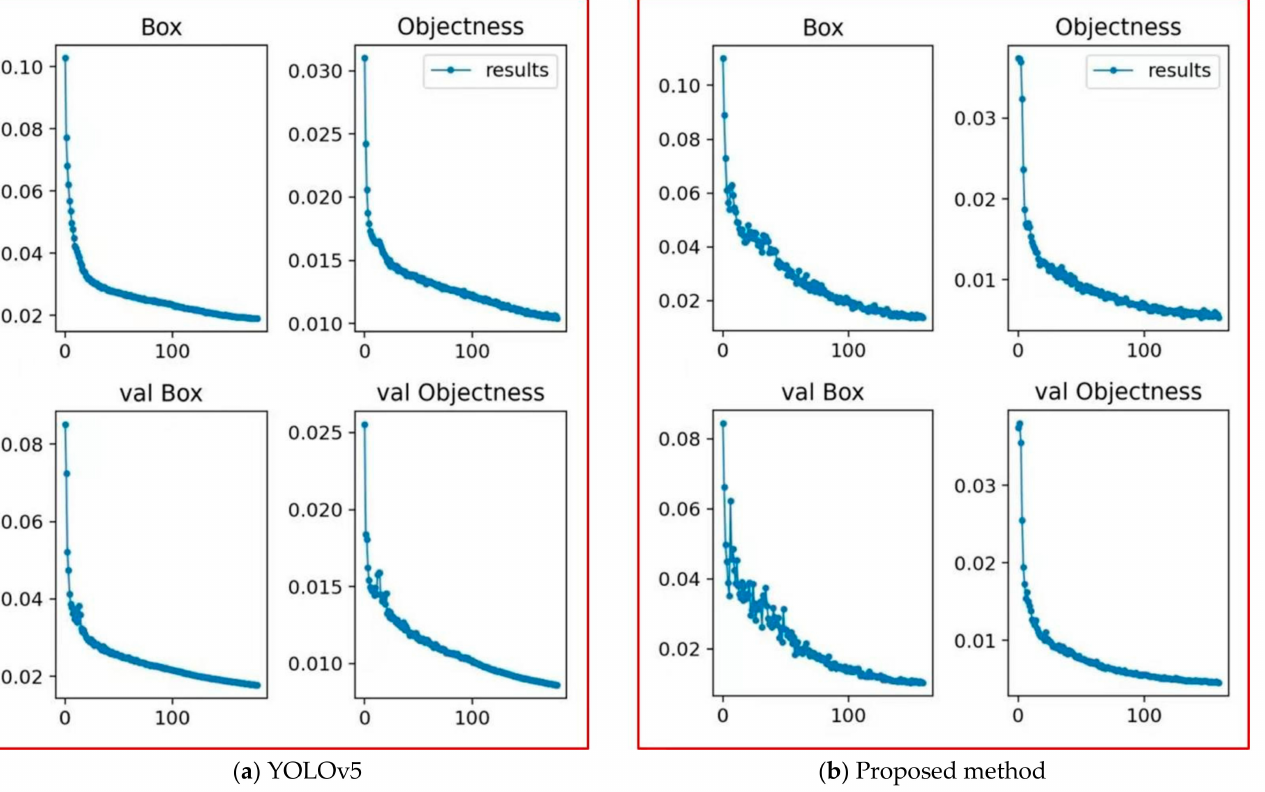
Figure 6. Comparison of the change curve between the loss value of the object box and the belief of the object